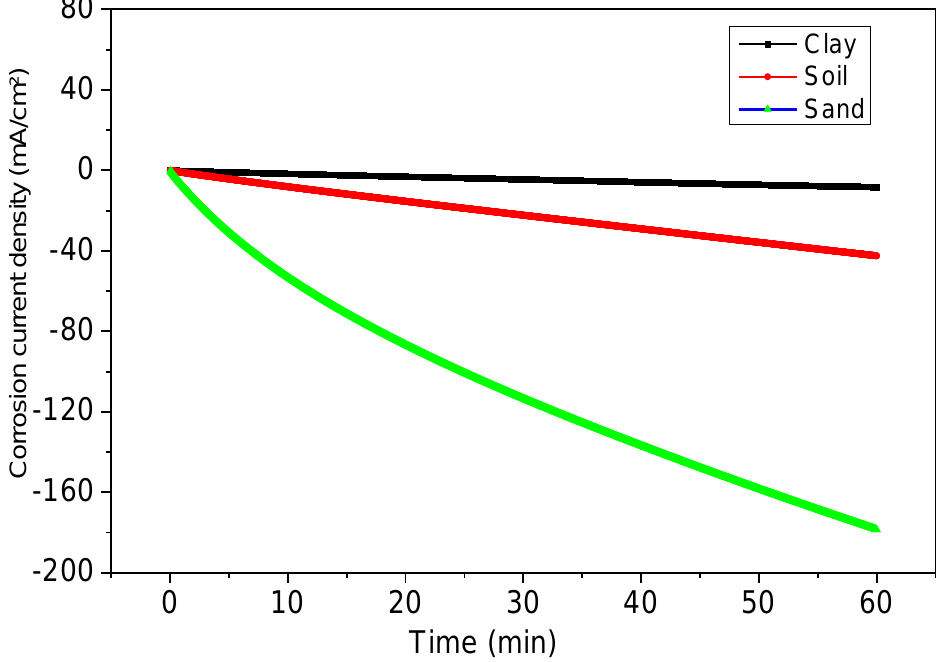
Figure 7. Potentiostatic polarization curve (cathodic loading) of coated steel for 1